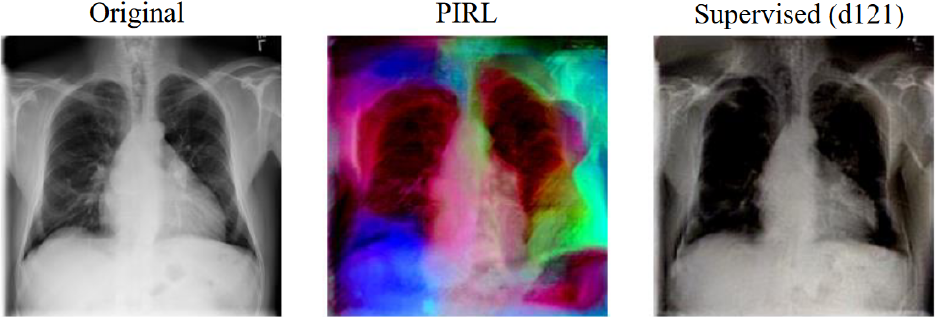
Figure 6. Deep image prior reconstructions for an image from the CheXpert dataset ( left ) for PIRL ( centre ) and Supervised DenseNet-121 ( right ). The original image is shown on the left for